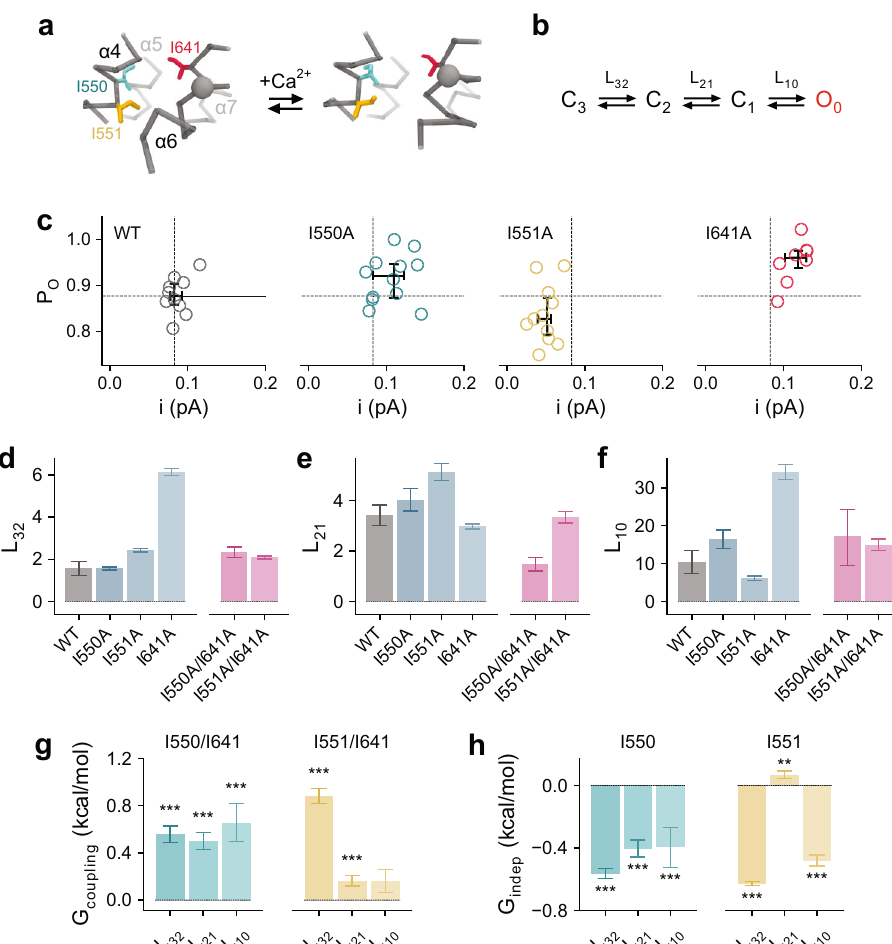
Fig. 3 Mechanistic double-mutant cycle analysis of residues of the gate region. a Conformational rearrangement of the inner pore entrance upon Ca 2 + binding. C α -trace of indicated transmembrane helices of the Ca 2 + -free (PDB: 5OYG) and the Ca 2 + -bound conformation of TMEM16A (PDB: 5OYB) are shown. Sidechains of residues of the gate are displayed as sticks, sphere indicates position of the gating hinge. b Reduced mechanism depicting gating transitions at saturating Ca 2 + concentrations. c Single-channel current (i) and open probability (Po) estimated from non-stationary noise analysis at saturating Ca 2 + concentrations. Circles correspond to individual data points. Bars refer to median and interquartile range of data. d – f Equilibrium constants for mutants in the gate region for transitions d , L 32 , e , L 21, and f , L 10 . Bars indicate the best- fi t values of the averaged data shown in Supplementary Fig. 7d (WT, n = 7; I550A, n = 6; I551A, n = 7; I641A, n = 7; I550A/I641A, n = 7; I551A/I641A, n = 6). Errors are 95% con fi dence intervals. g Coupling energy (G coupling ) and h independent energetic contribution (G indep ) of the indicated residues. Bars indicate quantities calculated using g , Eqs. 31 – 32, 35 and h , Eq. 34 from the best- fi t values shown in d – f . Errors correspond to standard errors. Asterisks indicate signi fi cant deviation from zero in a two-sided one- sample t -test ( g I550/I641: *** p = 2e − 8, *** p = 3e − 7, and *** p = 4e − 4; I551/I641: *** p = 1e − 13 and *** p = 0.001; h I550: *** p = 2e − 15, *** p = 6e − 8,